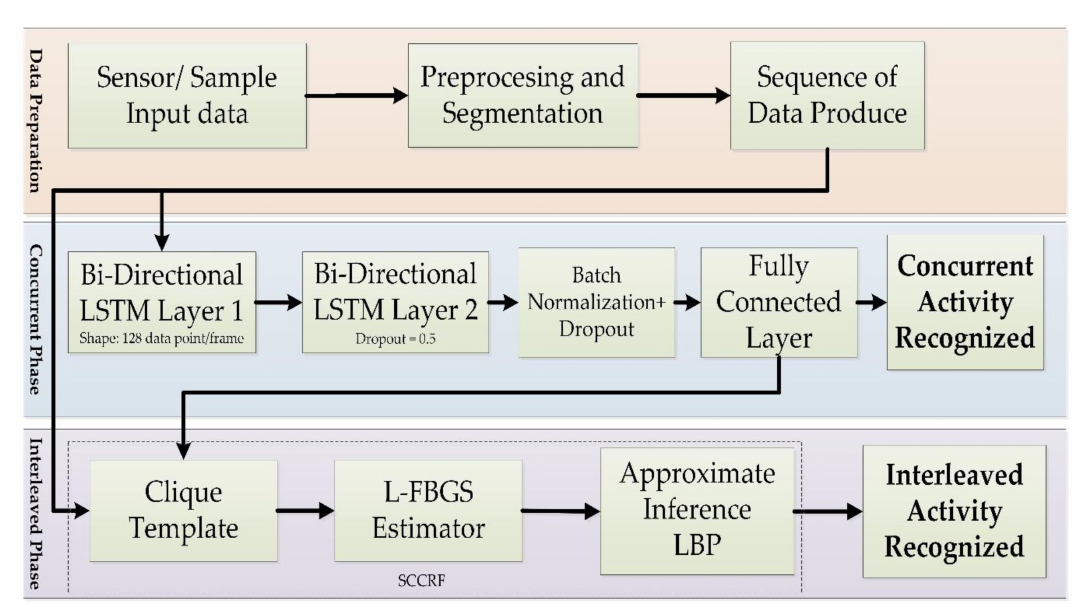
Figure 6. Proposed schematic architecture.